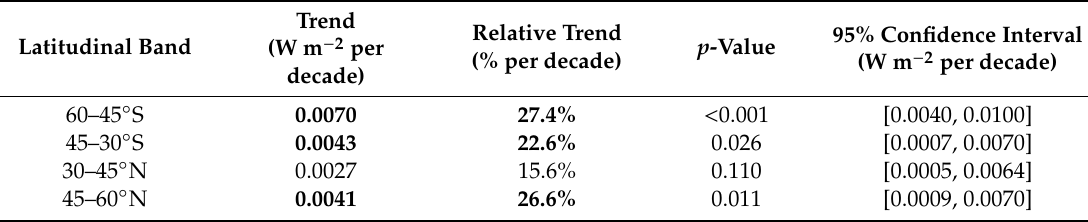
Table 1. ORF trends between 1982 and 2014 (considering 1979–1981 as a reference) in four di ff erent latitudinal belts. Statistically significant trends are highlighted in